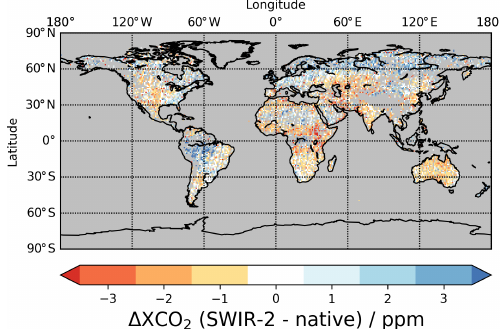
Figure 10. Differences between native GOSAT and SWIR-2 re- trievals averaged on 1 ◦ × 1 ◦ for 8 years of GOSAT observations. The global mean bias over land of 0.03ppm was subtracted from the